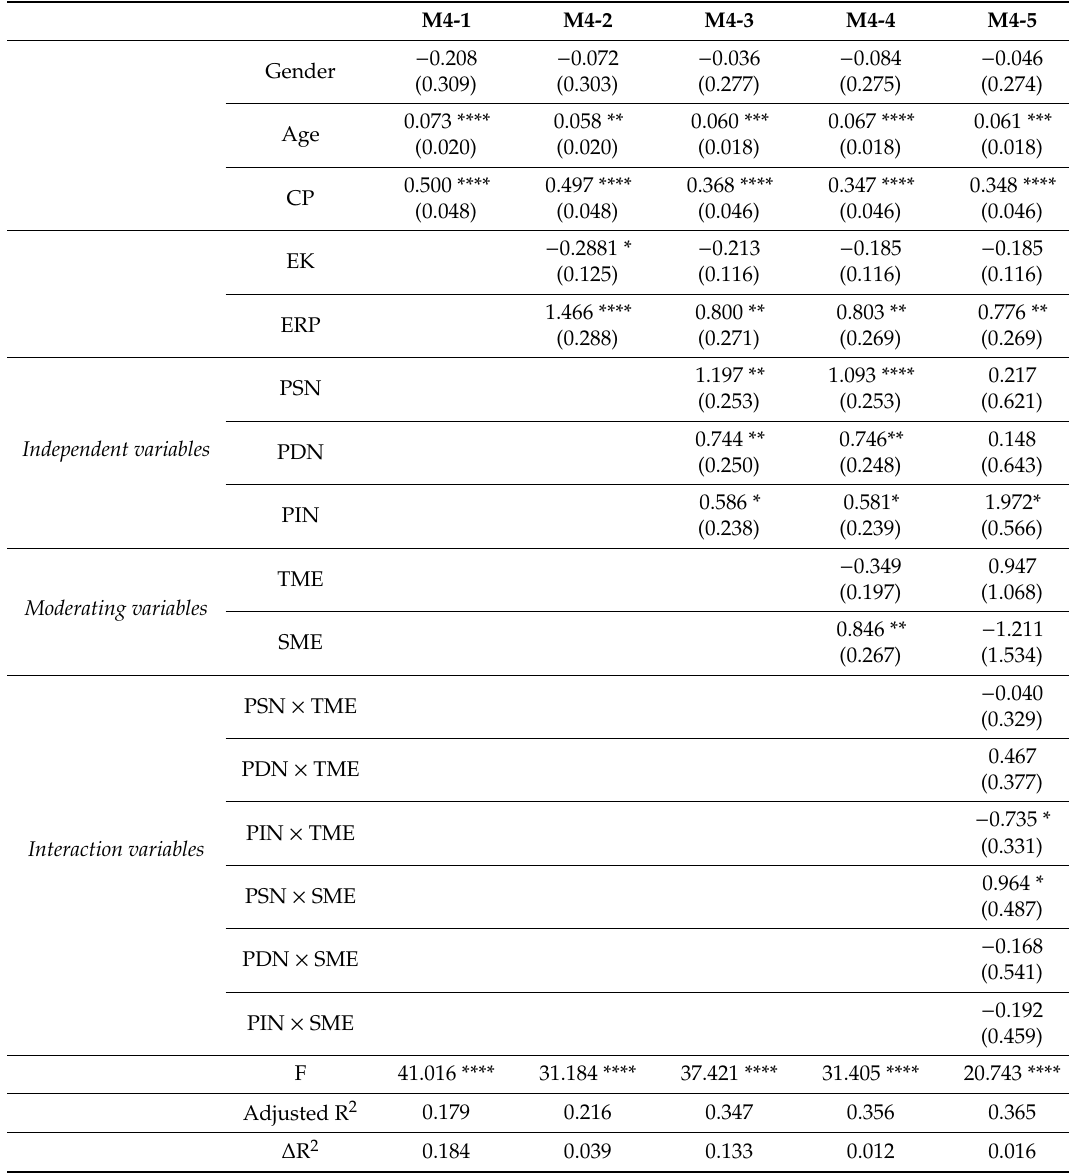
Table 4. Multiple regression analysis of the influence of di ff erent types of norm perception on pro-environmental behavior.